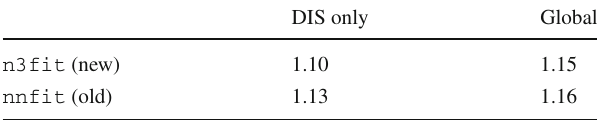
Table 5 Comparison of the total χ 2 of the fit for both a DIS only and Global setup between the old and new methodology